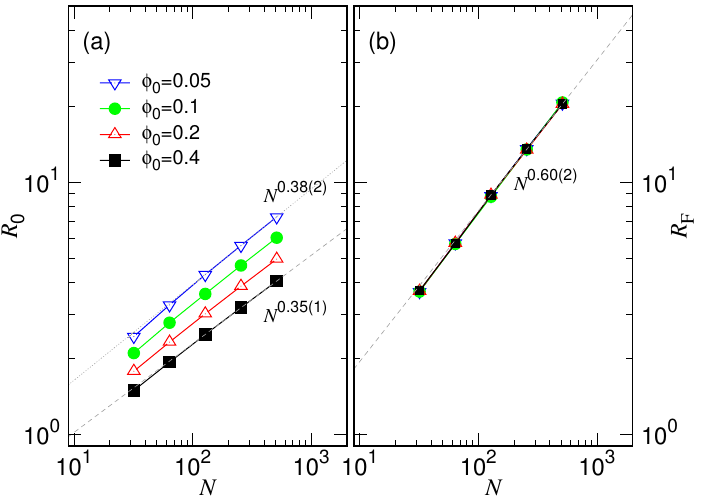
Figure 5. ( a ) The initial chain size R 0 vs. N and ( b ) the final chain size R F vs. N in the log–log plot. The value of φ 0 is given in the legend of Panel ( a